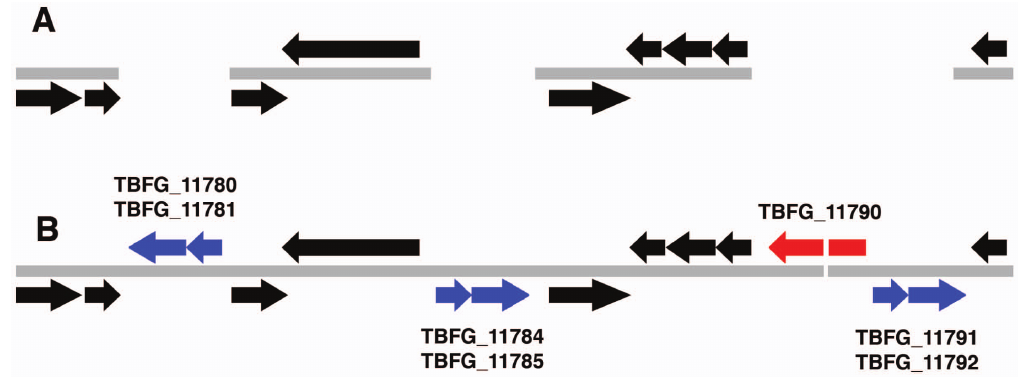
Figure 3. Comparative view of a transposase-rich region of the M.tuberculosis F11 genome (coordinates 1,991,000 to 2,006,300) obtained from the draft (A) and Pilon-improved (B) assemblies. In the draft assembly, three regions containing transposases (shown in blue) remained unassembled resulting in gaps. In the Pilon-improved assembly, all three sets of transposases were successfully assembled. The Pilon- improved assembly also contained a hypothetical gene, TBFG_11790 (shown in red), missing from the draft assembly. Though TBFG_11790 was not fully closed in the Pilon-improved version, closer inspection revealed that there was a 42 bp overlap in assembled sequence at this site. By default, Pilon will not close gaps unless there is at least 95 bp overlapping sequence to minimize spurious joins.